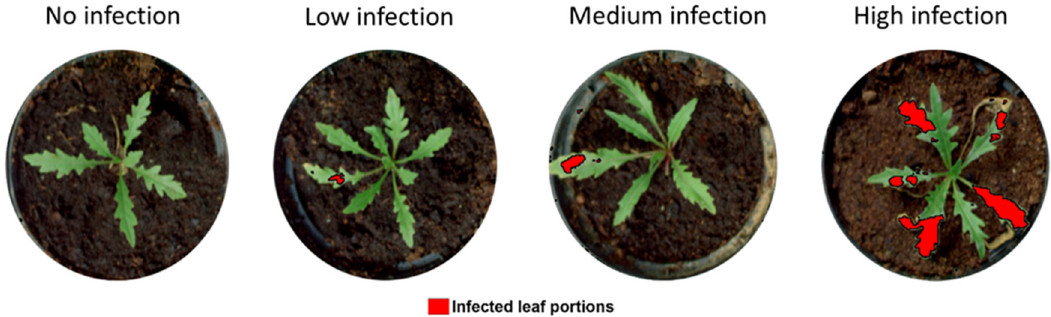
Figure 9. Disease classification by using the XGB2 model on four plants with known status of disease (from completely healthy to completely infected). The red sectors represent the pixels the model identified as infected.